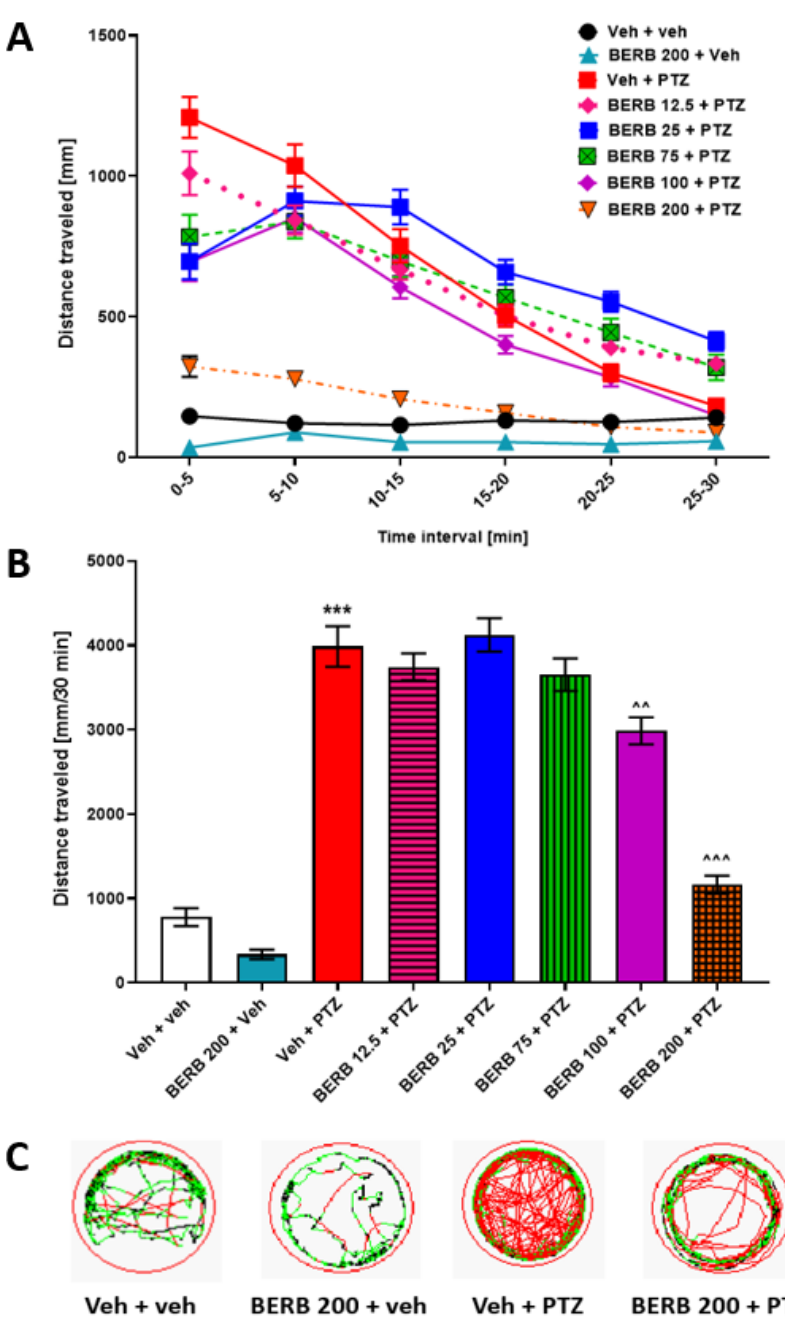
Figure 6. The influence of BERB on the seizure-like behavior in the PTZ-induced zebrafish hyperlocomotion assay. Seven dpf zebrafish larvae, after 24 h incubation with different doses of BERB (12.5, 25, 75, 100, or 200 µM), were exposed to 20 mM PTZ. Seizure-like behavior was assessed 5 min after acute PTZ exposure. Results of the assay are presented as ( A ) distance traveled in 5-min intervals, and ( B ) total distance traveled during 30 min of assay, ( C ) digital tracking map of larvae at second (5–10 min) interval of experiment: large movement—red, small movement—green. Data were analyzed using one-way or two-way with repeated measures ANOVA followed by the Tukey’s or Bonferroni’s post-hoc test, respectively. Data are depicted as a mean ± SEM. Veh + veh ( n = 36), BERB 200 + veh ( n = 29), Veh + PTZ ( n = 48), BERB 12.5 + PTZ ( n = 48), BERB 25 + PTZ ( n = 48), BERB 75 + PTZ ( n = 48), BERB 100 + PTZ ( n = 48), BERB 200 + PTZ ( n = 48). *** p < 0.001 vs. Veh + veh; ˆˆˆ p < 0.001, ˆˆ p < 0.01 vs. Veh + PTZ. BERB—berberine, PTZ—pentylenetetrazole,